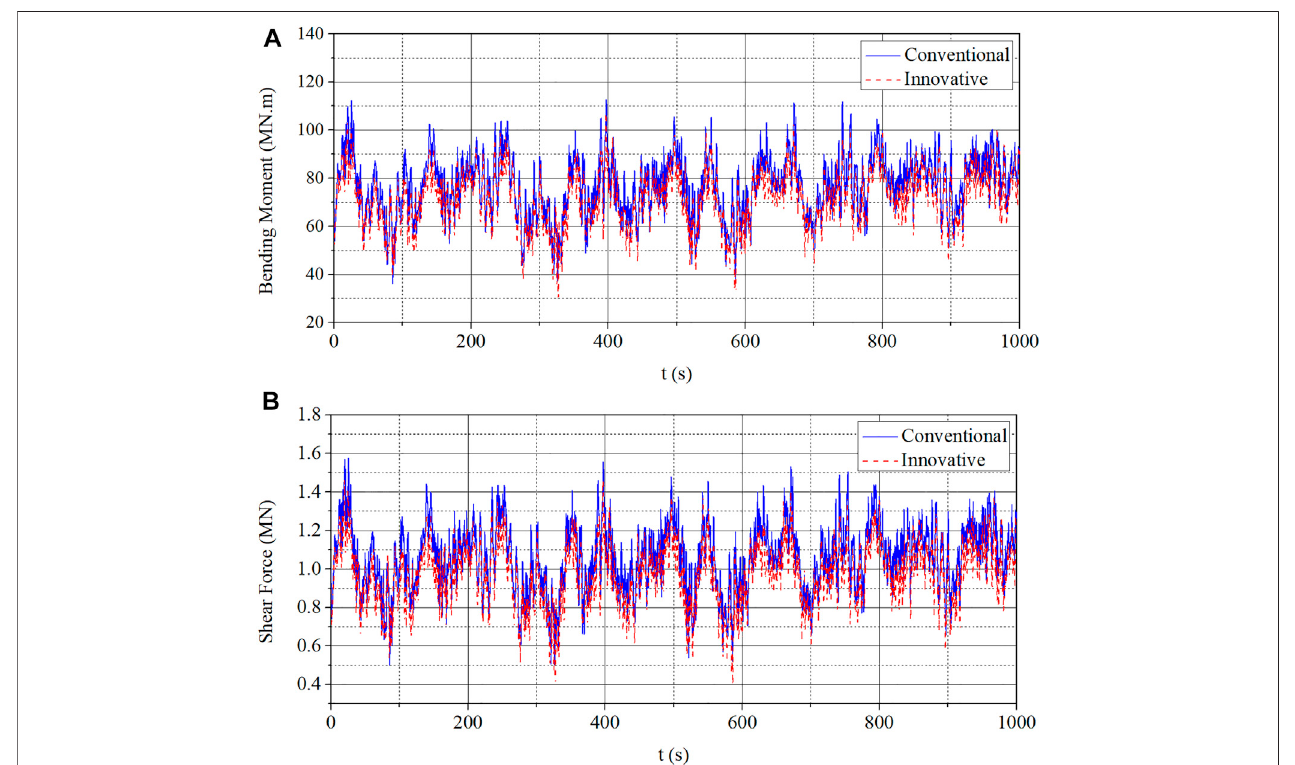
FIGURE 10 | Structural loads at tower base. (A) Bending moment. (B) Shearing